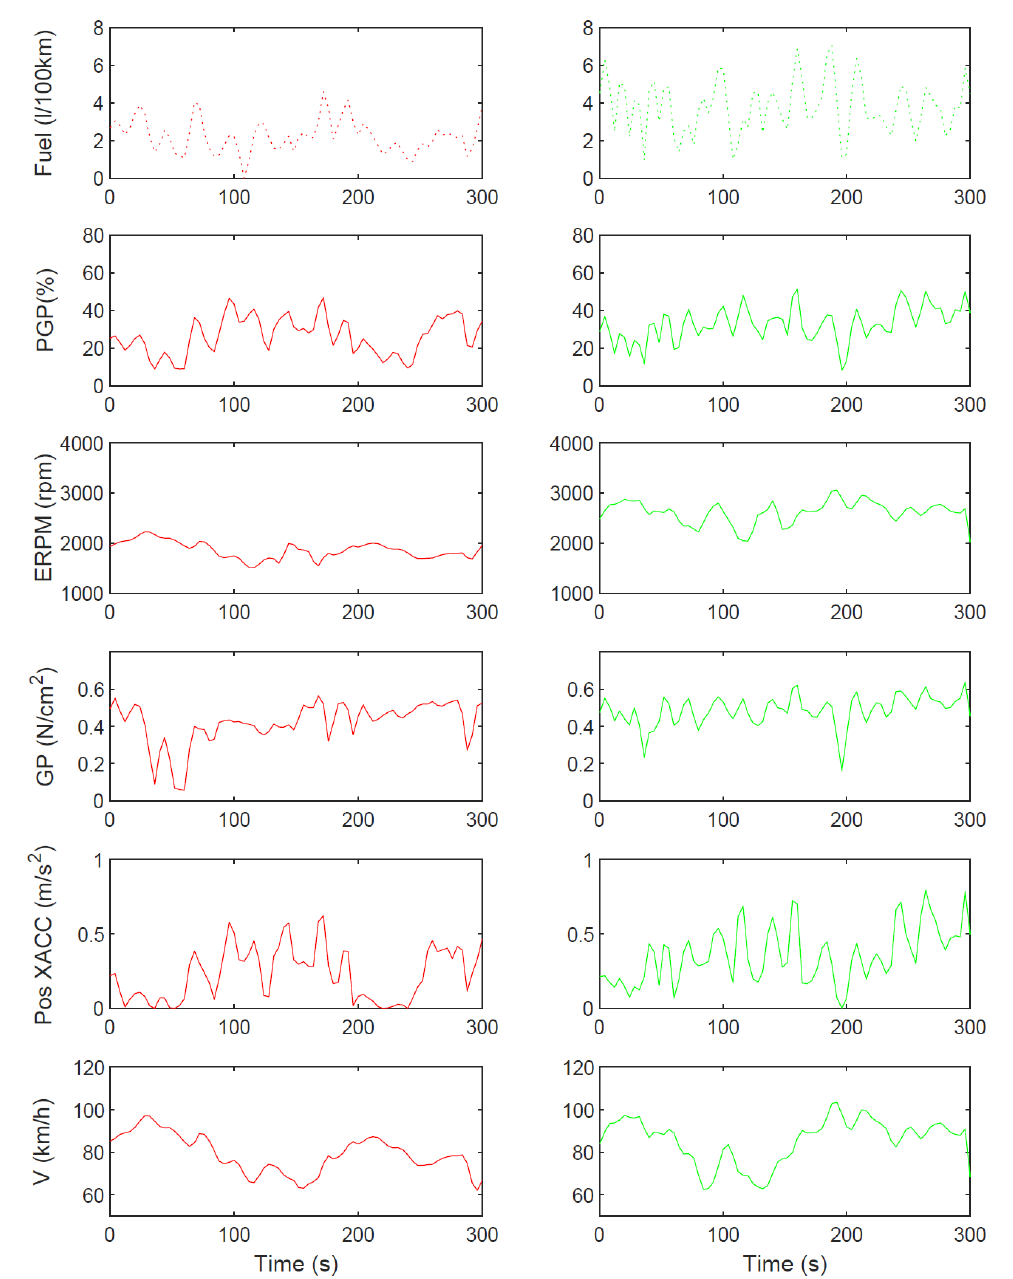
Figure 11. Uyanik measurement of relevant CAN-bus and IMU signals corresponding to D1 (green) and D11 (red) during five uninterrupted minutes of the route. The driving behavior was evaluated every 100 s, and the cluster with the maximum percentage was selected. Both D11 and D1 were classified into a single cluster during the whole segment of the trip: D11 drives according to the Very low cluster, and D1’s driving style is mostly into the Medium cluster. GT-Suite simulations of fuel consumption are also